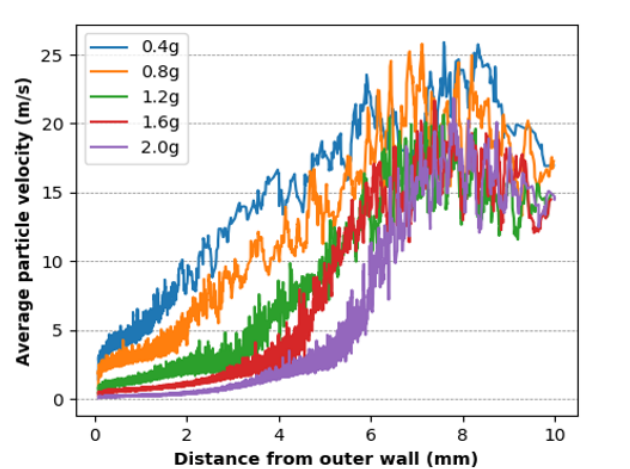
Fig 3: Radial velocity profile from the outer